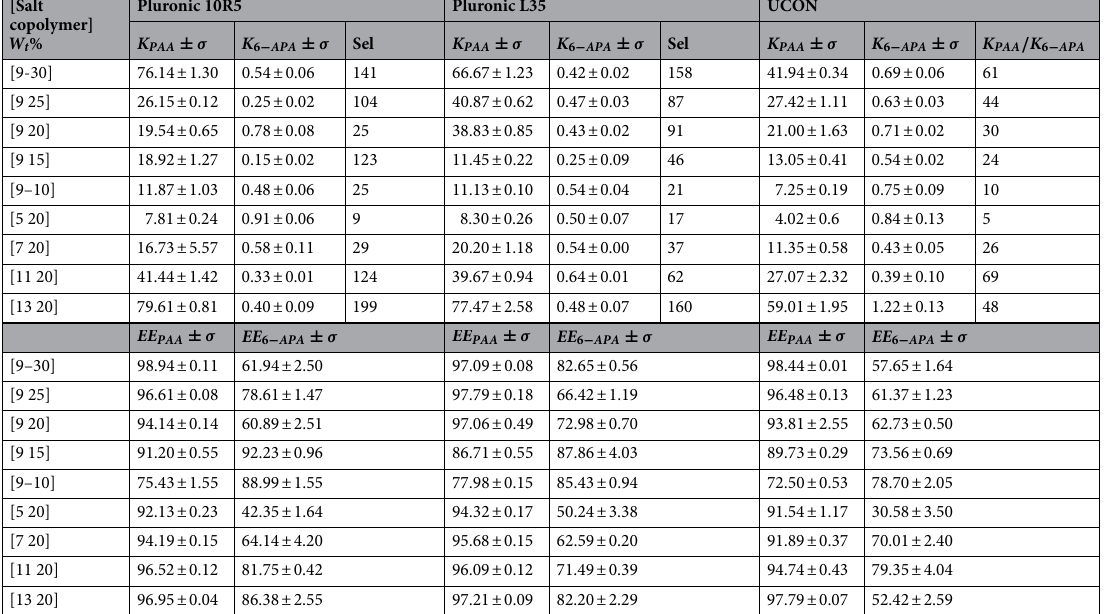
Table 3. Weight percentage composition of each mixture point tested ( W t %), partition coefficient (K), extraction efficiency (EE%) and selectivity (Sel.) for systems based in copolymers and Na 2 SO 4 .